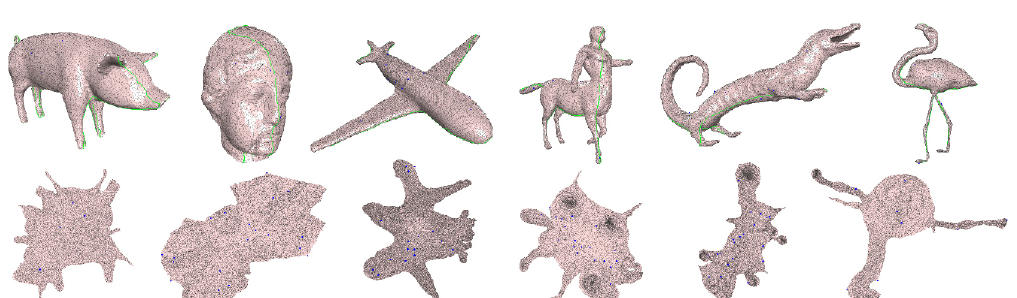
Fig. 10 Three different scaffold meshes.